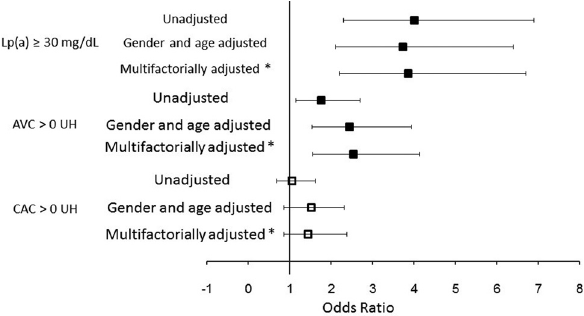
Figure2 -Multivariateregressionanalysisdemonstratingtheindependent association between the LPA rs10455872- G allele and Lp(a) (cid:2) 30 mg/dL, AVC > 0 AU and CAC > 0 HU in a Mexican-Mestizo population. * ad- justed for gender, age, BMI, triglycerides, LDL-C, diabetes mellitus, hy- pertension, and